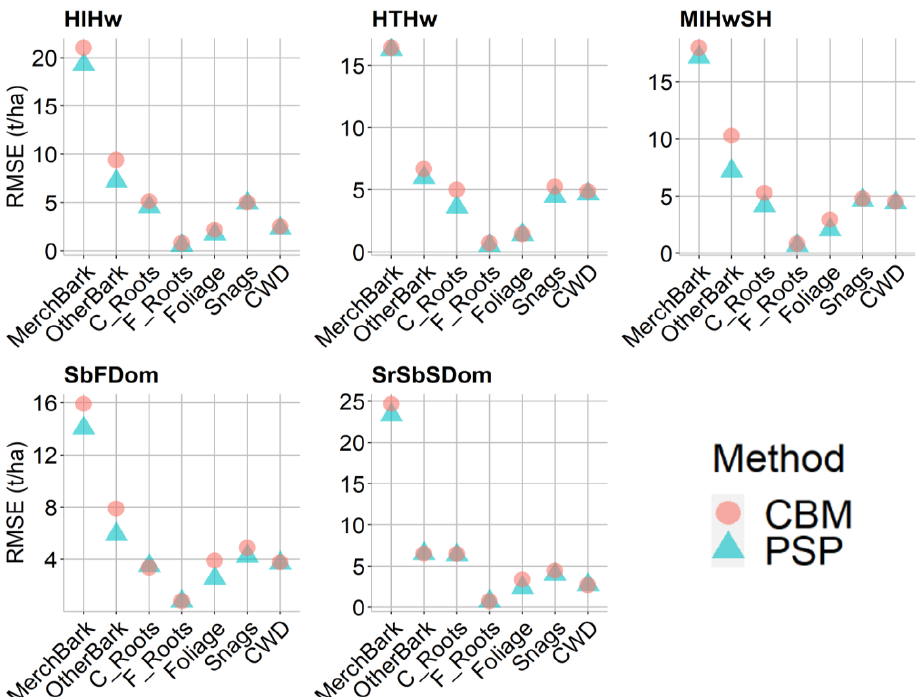
Figure 6. Root Mean Square Error (RMSE) of both estimation methods against an independent PSP dataset ( n = 100 per community), by forest community and carbon pool.